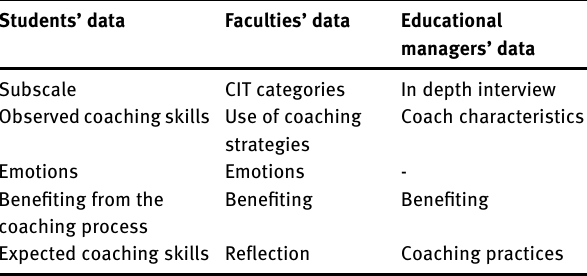
Table  : The integration of the data from educational managers, faculty, and